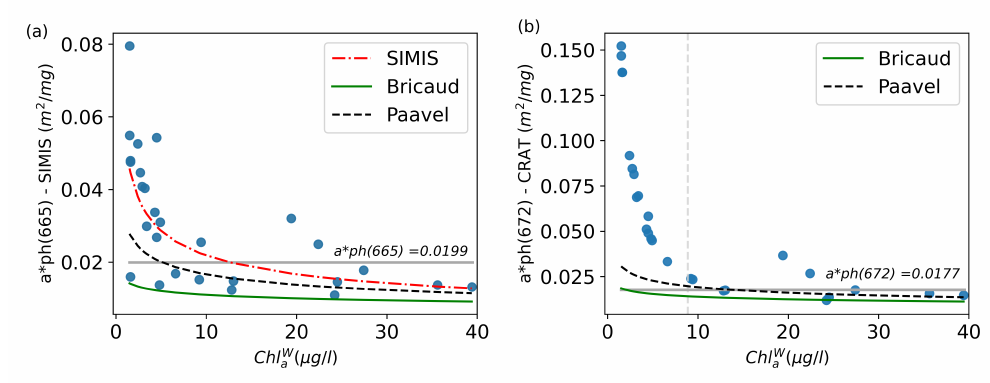
Figure 6. Dependence of a ∗ ph ( 665 ) ( a ) and a ∗ ph ( 672 ) ( b ) on Chl a concentrations from the water sampling ( Chl W a ) for the SIMIS and the CRAT algorithm, respectively. Equations found by [41,44] are also added (see color legend). Horizontal gray lines show the fixed a ∗ ph ( λ ) . Dashed vertical gray line shows the limit at 8 µ g/L for the application of the CRAT algorithm ( b ).